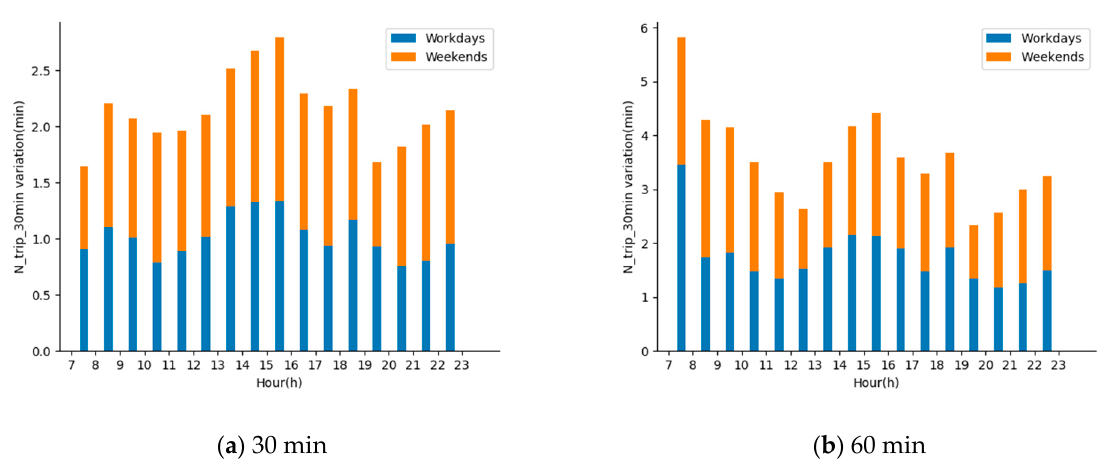
Figure 7. The growth in cruising duration year on year in May: ( a ) cruising trips within 30 min; ( b ) cruising trips within 60 min.